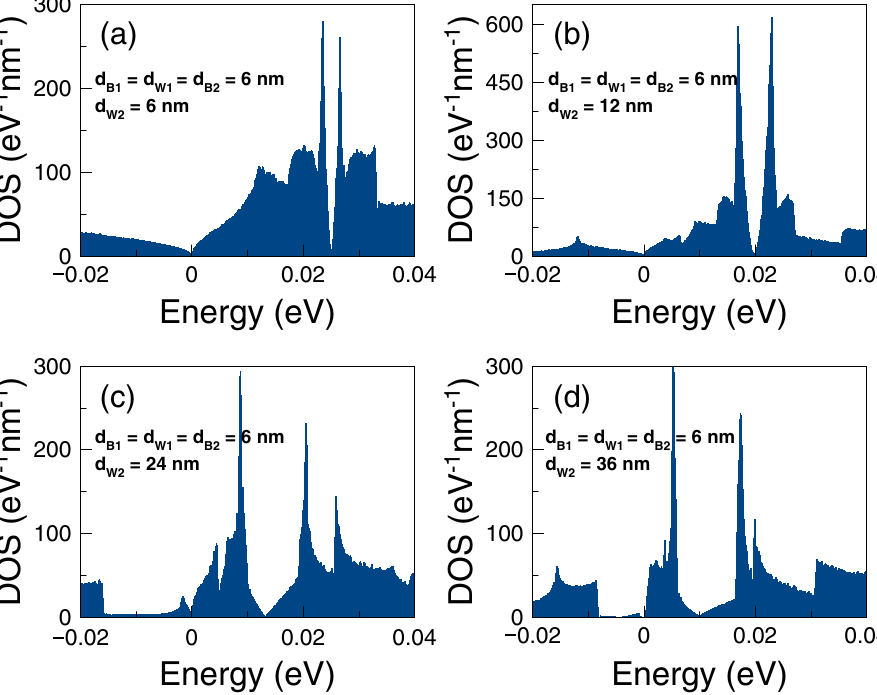
Figure 15. Density of states versus the energy for gapless bilayer graphene double barriers of d B = d W = 6 nm. Here, the width of the second well d W 2 is varied to mimic the conditions for double barriers. The height of the barriers is V 0 = 50 meV. In this case, as d W 2 increases the electron states accumulate around the Breit–Wigner and Fano resonances energy